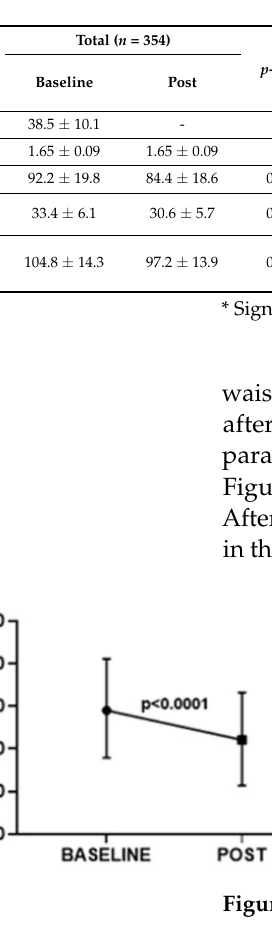
Figure 2. Representation of variation in weight (kg, ( A )), BMI (kg/m 2 , ( B )), and waist circumference (cm, ( C )), presented as the mean and SD, of all the volunteers enrolled in the present study, both before (BASELINE) and after (POST) 4 Phases Methodology application.